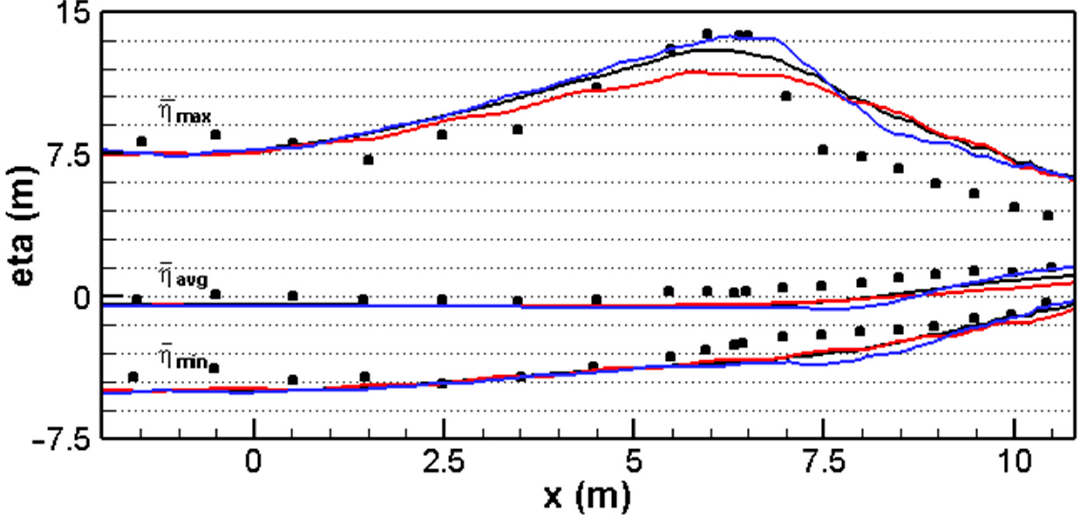
Figure 7. Results 3: minimum, average and maximum water surface elevations in Configuration WS, showing numerical results (blue solid line C s = 0.1, black solid line C s = 0.2, red solid line C s = 0.3) and experimental measurements (circles) [3].